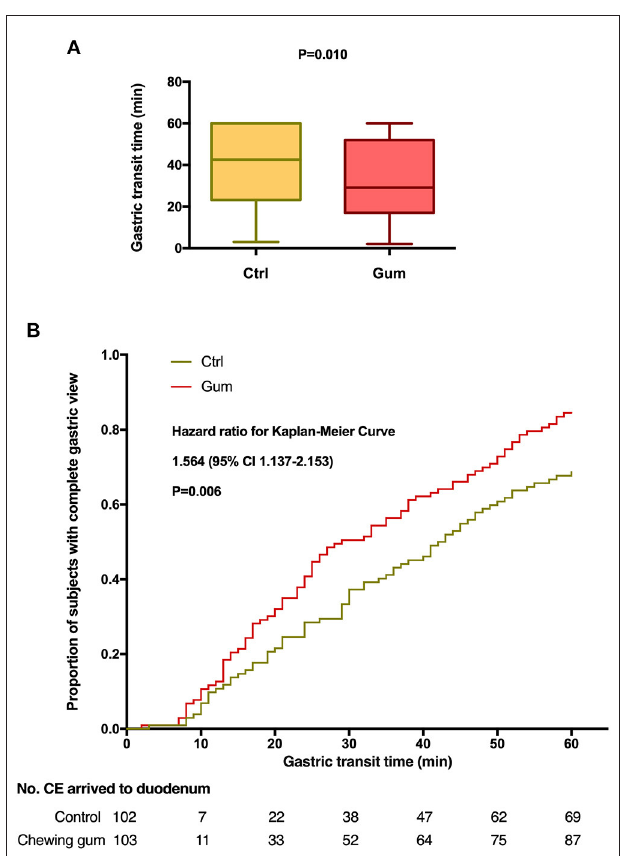
FIGURE 2 | Gastric transit time during capsule endoscopy in the chewing gum group and control group. (A) A boxplot with medians and quartiles; (B) Kaplan–Meier curves for time to complete gastric view.